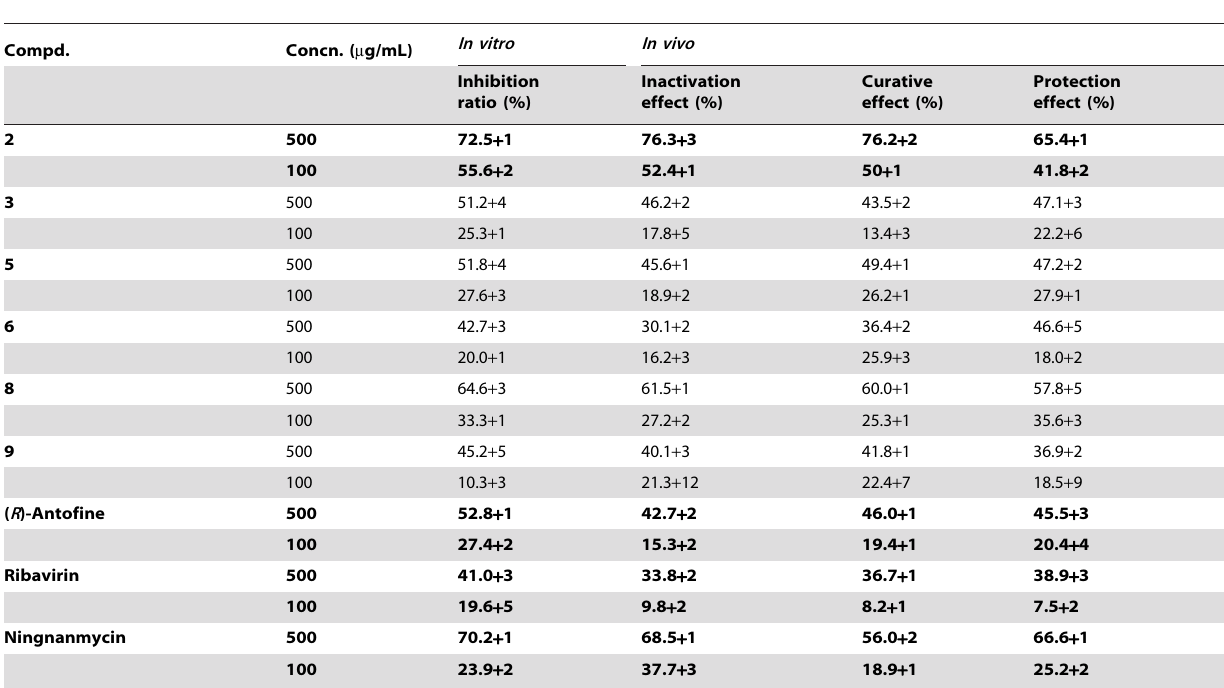
Table 2. In vitro and in vivo anti-TMV activity of chiral phenanthroquinolizidine alkaloids 2, 3, 5, 6, 8 and 9.